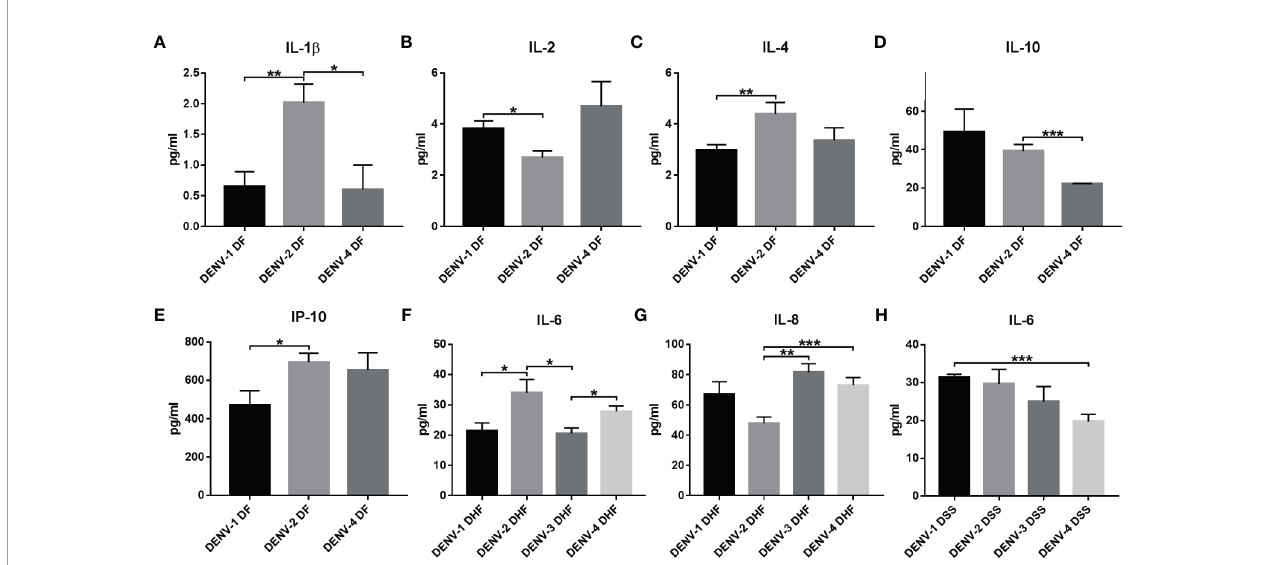
FIGURE 7 | Cytokine expression within serotypes with respect to dengue severity (DF, DHF, and DSS). The graph represents the cytokine expression in dengue severity within DENV serotypes. The cytokines IL-1 b (A) , IL-2 (B) , IL-4 (C) , IL-10 (D) , and IP-10 (E) show statistically signi fi cant expression in DF within different serotypes. IL-6 (F) and IL-8 (G) show signi fi cant expression between serotypes in DHF. IL-6 (H) shows signi fi cant expression within serotypes in DSS. Statistical signi fi cance is shown in asterisk (*) mark. * P < 0.05, ** p < 0.01, *** p < 0.001. The error bars represent SEM. [DF-DENV-1 (N=4), DENV-2 (N=14), DENV-4 (N=3); DHF-DENV-1 (N=5), DENV-2 (N=5), DENV-3 (N=4), DENV-4 (N=21); DSS-DENV-1 (N=5), DENV-2 (N=3), DENV-3 (N=3), DENV-4